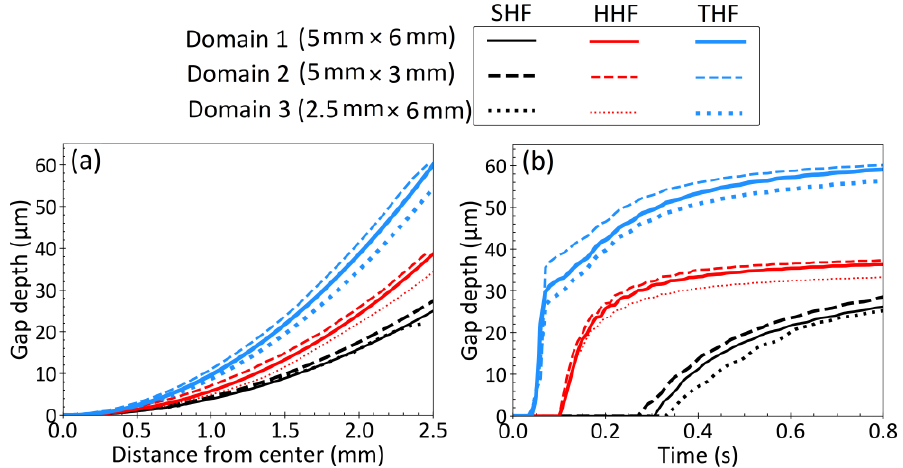
Figure 12. Effect of droplet domain shape and heat flux on gap depth for 0.10%C steel; ( a ) Final gap depth profiles; ( b ) Gap depth evolution at early times.